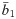
Parameter estimation in models of evolution.(A) Dependence of b¯1 on the recombination rate parameter for a set of 1,000 simulations of a basic coalescent model. Each simulation consists of 200 sequences, 30 kilobase long. The expected b¯1 of the barcode ensemble grows monotonically with the recombination rate, providing a good measure of the later. The smoothed average is shown in red. (B) Dependence of the average death time, 〈ϵd〉, on the migration rate of two divergent populations with fixed recombination and variable migration rates, based on 900 simulations. Each simulation consists of 150 sampled sequences, 10 kilobase long. The same structure as in Fig 8 was considered for the two populations. The expected value of 〈ϵd〉 decreases monotonically with the migration rate, being informative of the later.